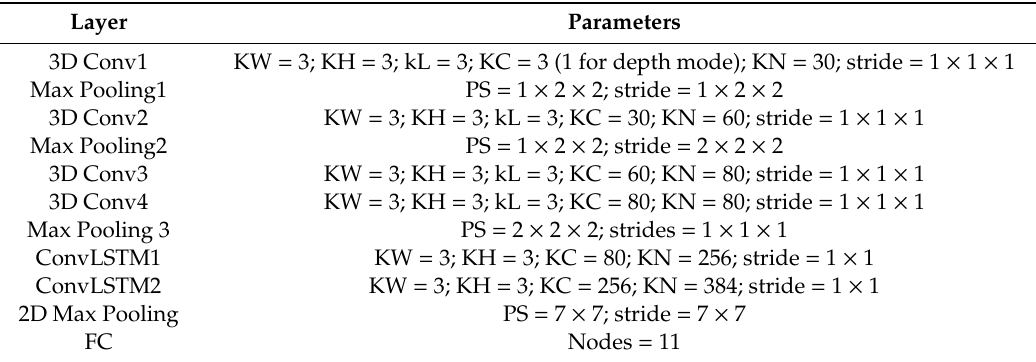
Table 1. Details of the 3DCNN-ConvLSTM used in the model.